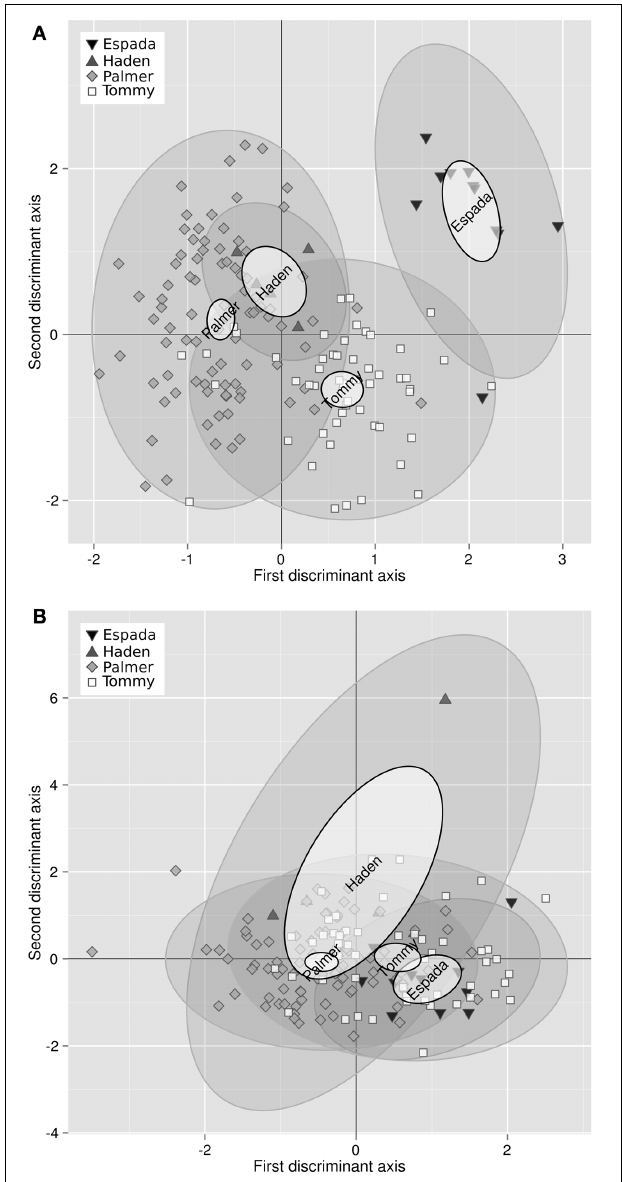
FIGURE 1 | (A) Discriminant analysis of the ionomes of four varieties and (B) their soil properties (right) in mango orchards in the state of São Paulo, Brazil: “Palmer” (93obs.), “Tommy” (63obs.), “Espada” (14obs.) and Haden (5obs.). Large semitransparent ellipses that enclose swarms of data points represent regions that include 95% of the theoretical distribution of canonical scores for each species. Smaller plain white ellipses represent confidence regions about means of canonical scores at 95% confidence level.